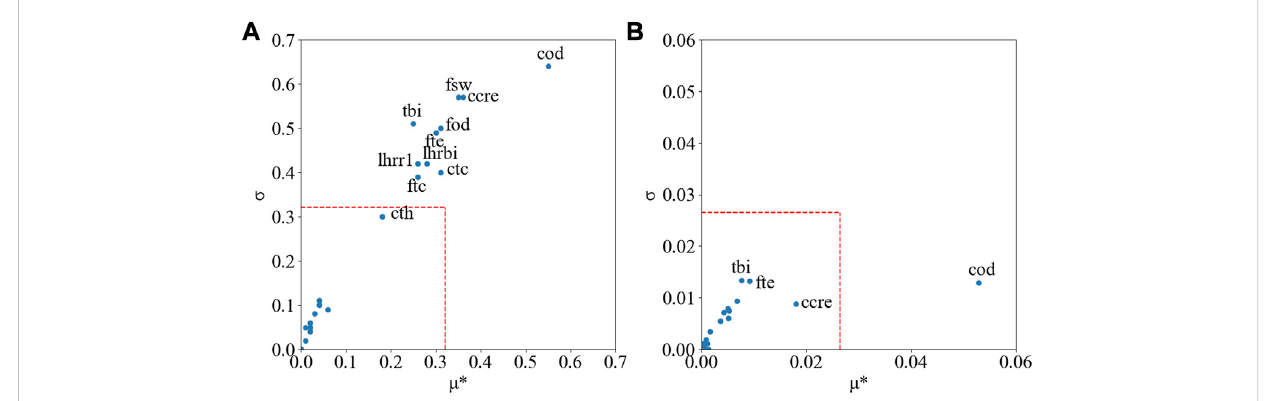
FIGURE 5 (A) Morris results for the maximal cladding axial elongation (B) Morris results for the average cladding outer diameter after the cold ramp. The dash lines represent the cut-off limits.